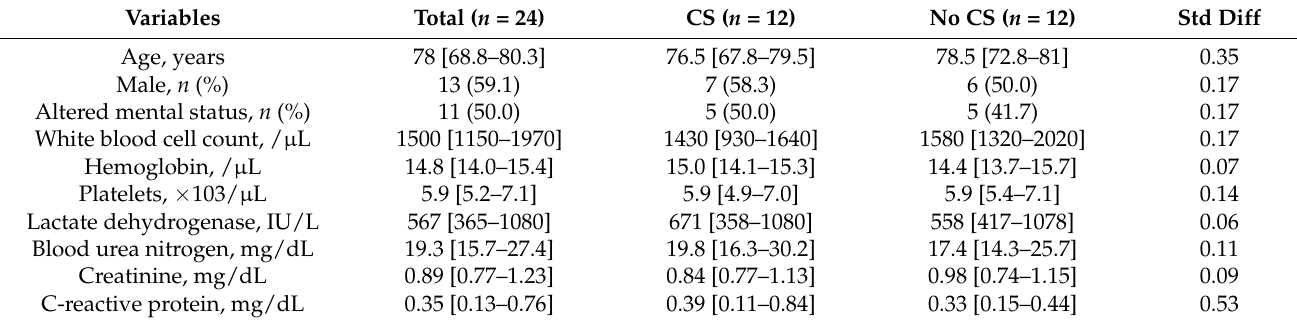
Table 4. Clinical characteristics of the subjects according to CS use after propensity score